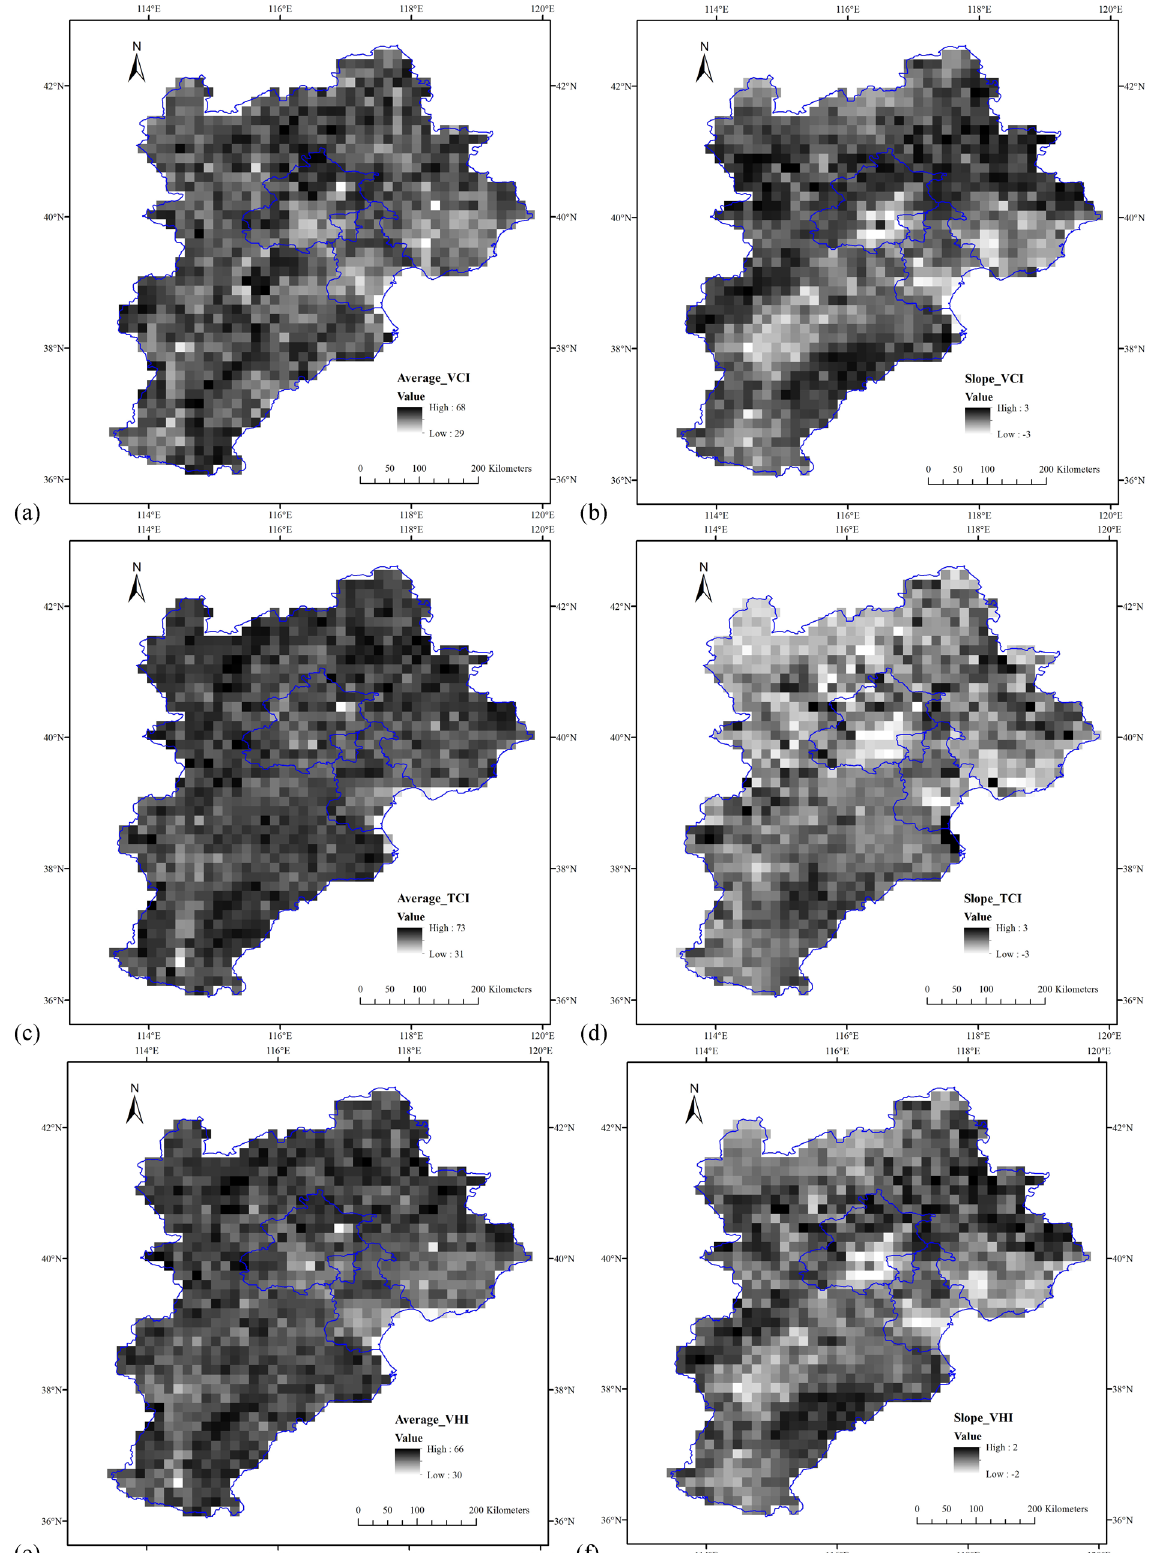
Figure 3. Spatial distributions of thirty-five year average values and slopes of VHIs during growing season for the period of 1982–2016 in Jing-Jin-Ji region. ( a ) average values of VCI, ( b ) trends of VCI, ( c ) average values of TCI, ( d ) trends of TCI, ( e ) average values of VHI, and ( f ) trends of